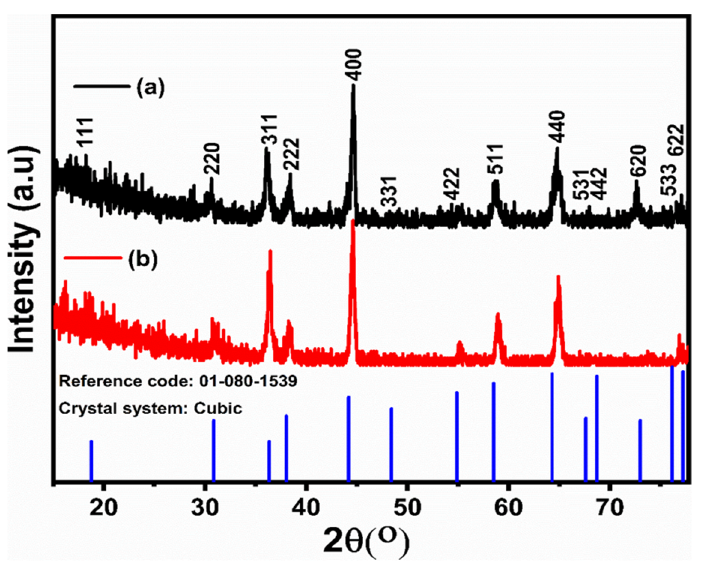
Figure 1. ( a ) XRD patterns of pure Co 3 O 4 and ( b ) Co 3 O 4 nanocrystals prepared with polyethylene-imine.